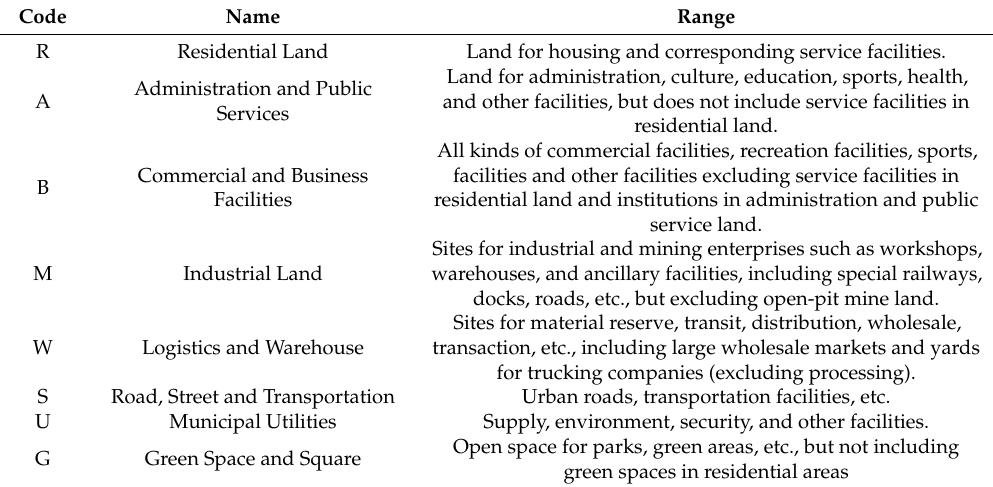
Table 1. Urban development land classification and code.